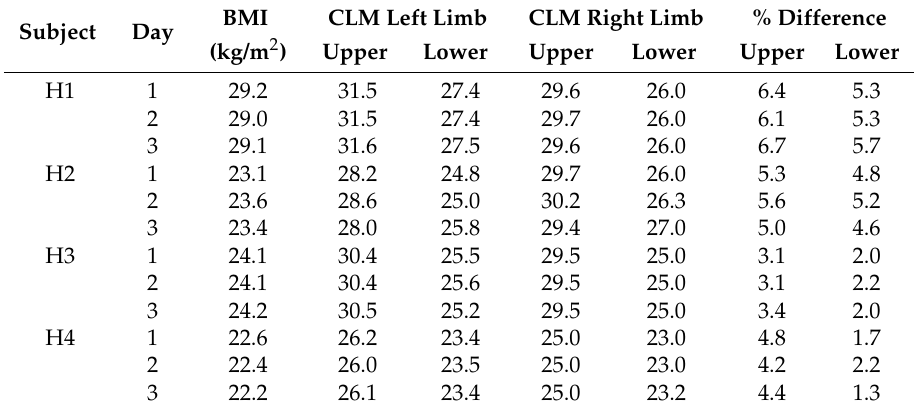
Table 2. CLM measured in centimetres on healthy (H)